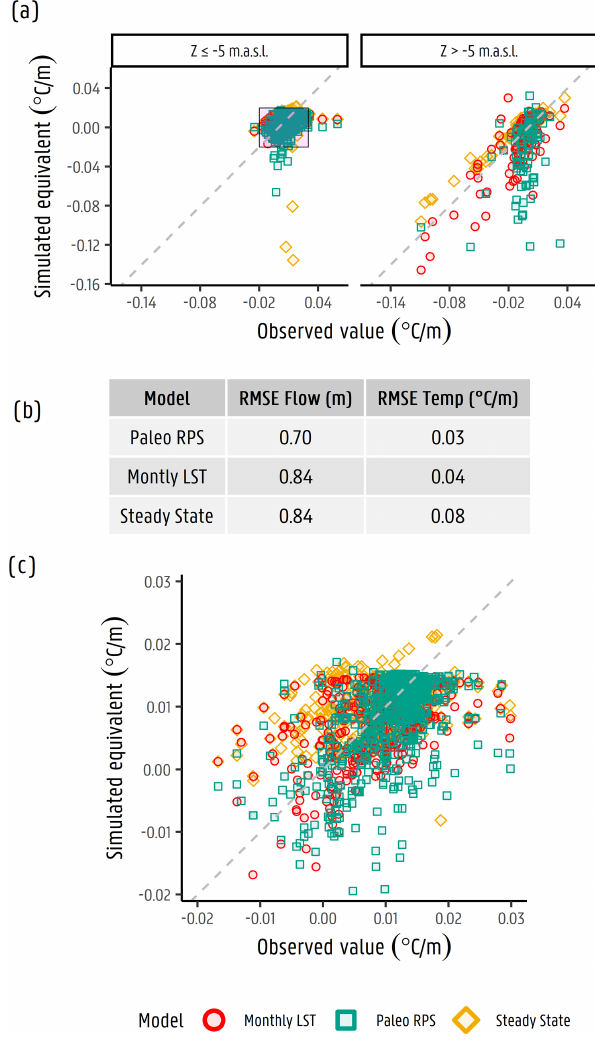
Figure 6. Simulated vs. observed temperature gradients showing re- sults from the steady-state model and the monthly LST model and reconstructed paleo-temperatures included as input into the tran- sient model. (a) A distinction is made between observations below and above z = − 5ma.s.l. (b) The RMSE performance of different models in terms of the hydraulic head (flow model, m) and temper- ature gradient ( ◦ Cm − 1 ). (c) A magnification of the simulated and observed temperature gradients shown in panel (a)